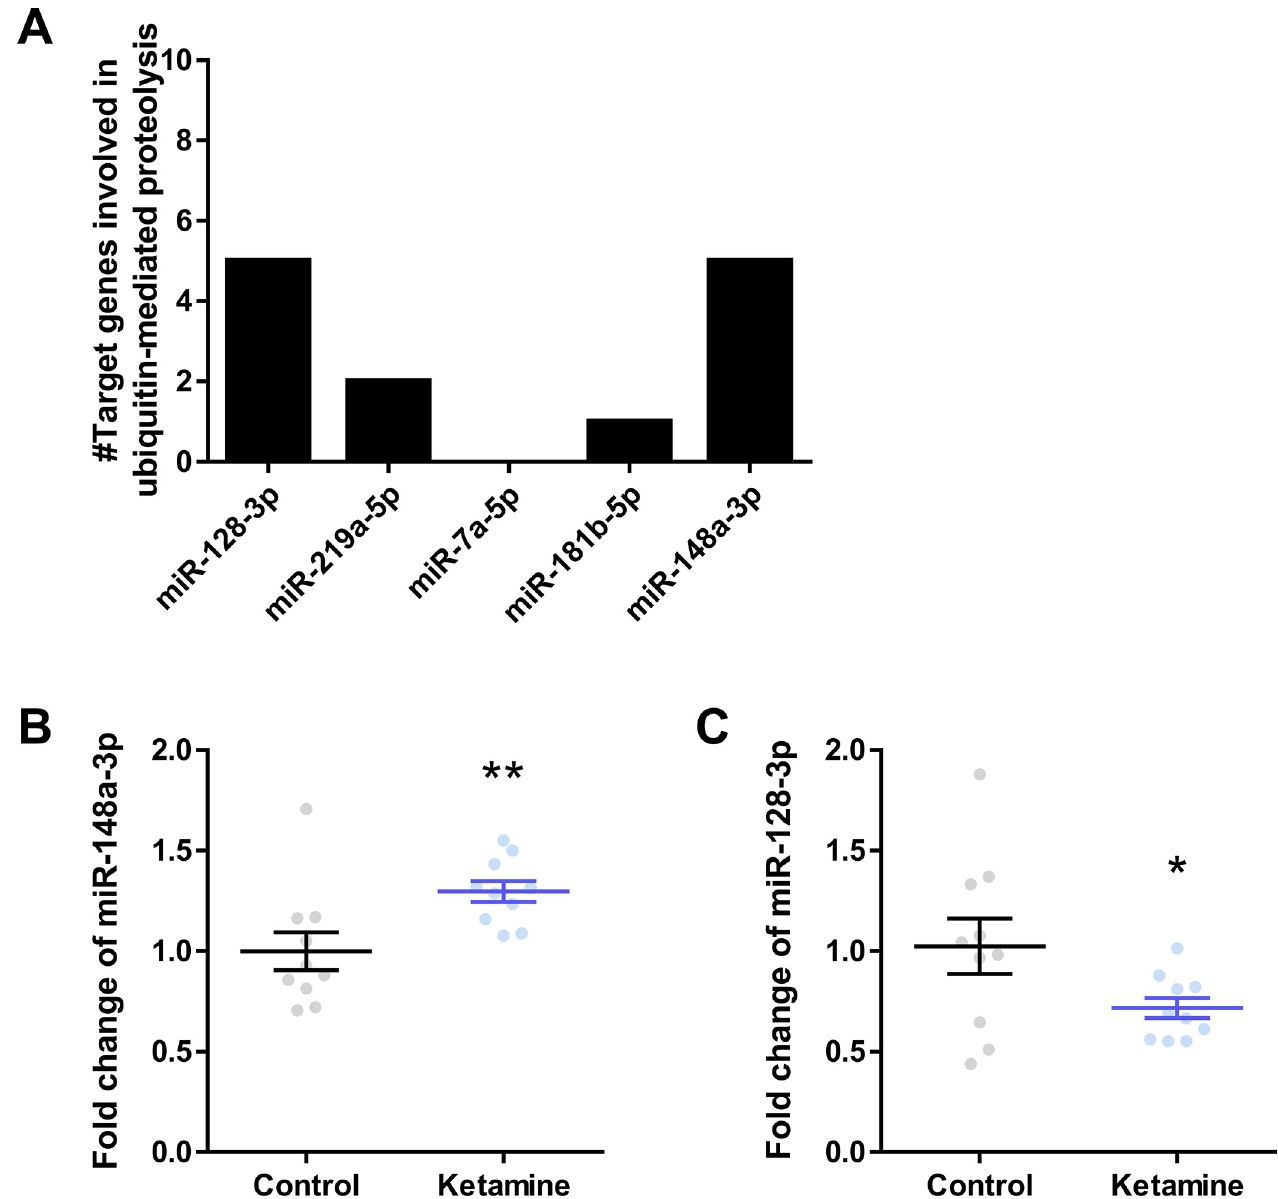
Fig 3. miR-148a-3p and miR-128-3p as the principal miRNA substrates for acute subanesthetic ketamine. (A) Number of genes involved in ubiquitin- mediated proteolysis targeted by the 5 miRNAs. The miRNA qPCR result of (B) miR-148a-3p and (C) miR-128-3p. � p-value < 0.05, �� p-value < 0.01.